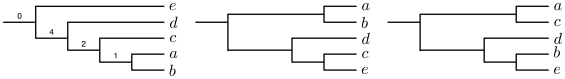
A case in which the optimal tree under the MDC criterion contains at least one cluster that does not occur in any of the input gene trees.Three gene trees over the taxon-set {a, b, c, d, e}. The tree that minimizes the total number of extra lineages and that consists of only clusters induced by those three trees is the leftmost one. It requires seven extra lineages to reconcile all three gene trees.